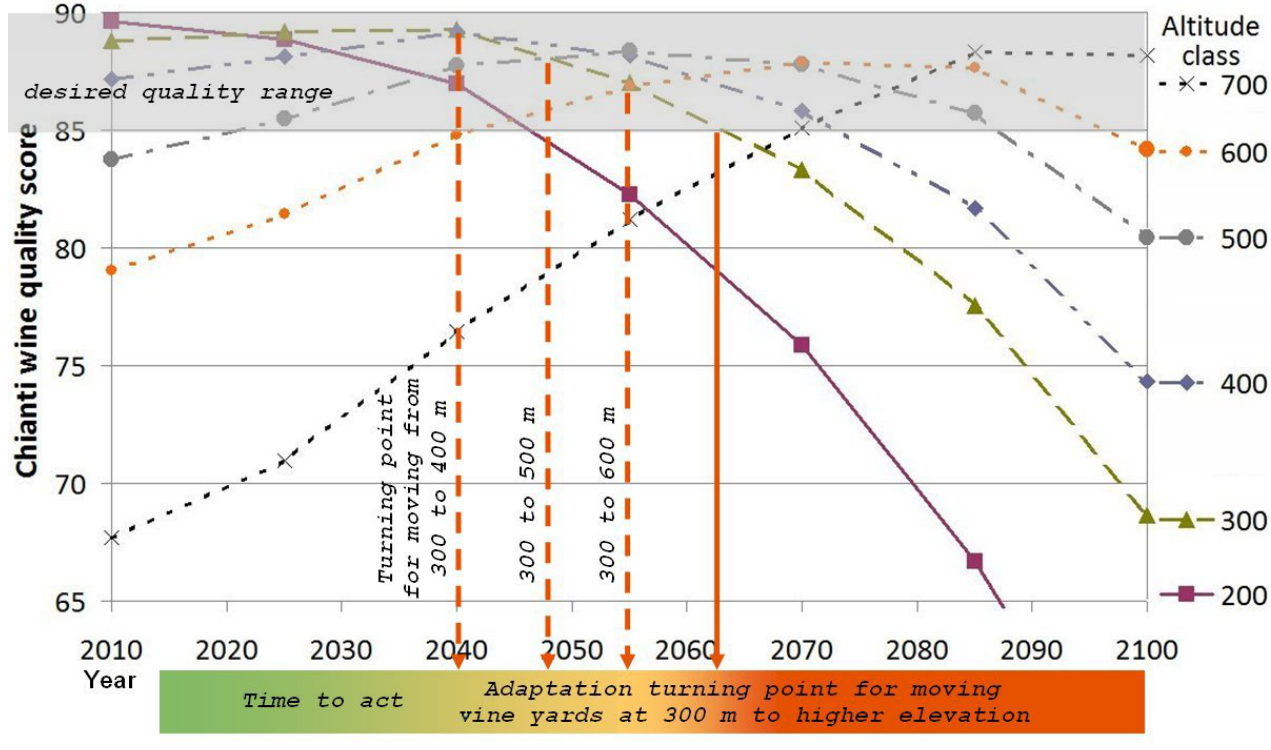
Fig. 3 . Adaptation turning point for Chianti production in Tuscany. The figure shows quality scores in different elevation classes (average of the climate models DMI-HIRHAM, ETHZ-CLM, MPI-M-REMO, and SMHIRCA) for Special Report on Emissions Scenarios scenario